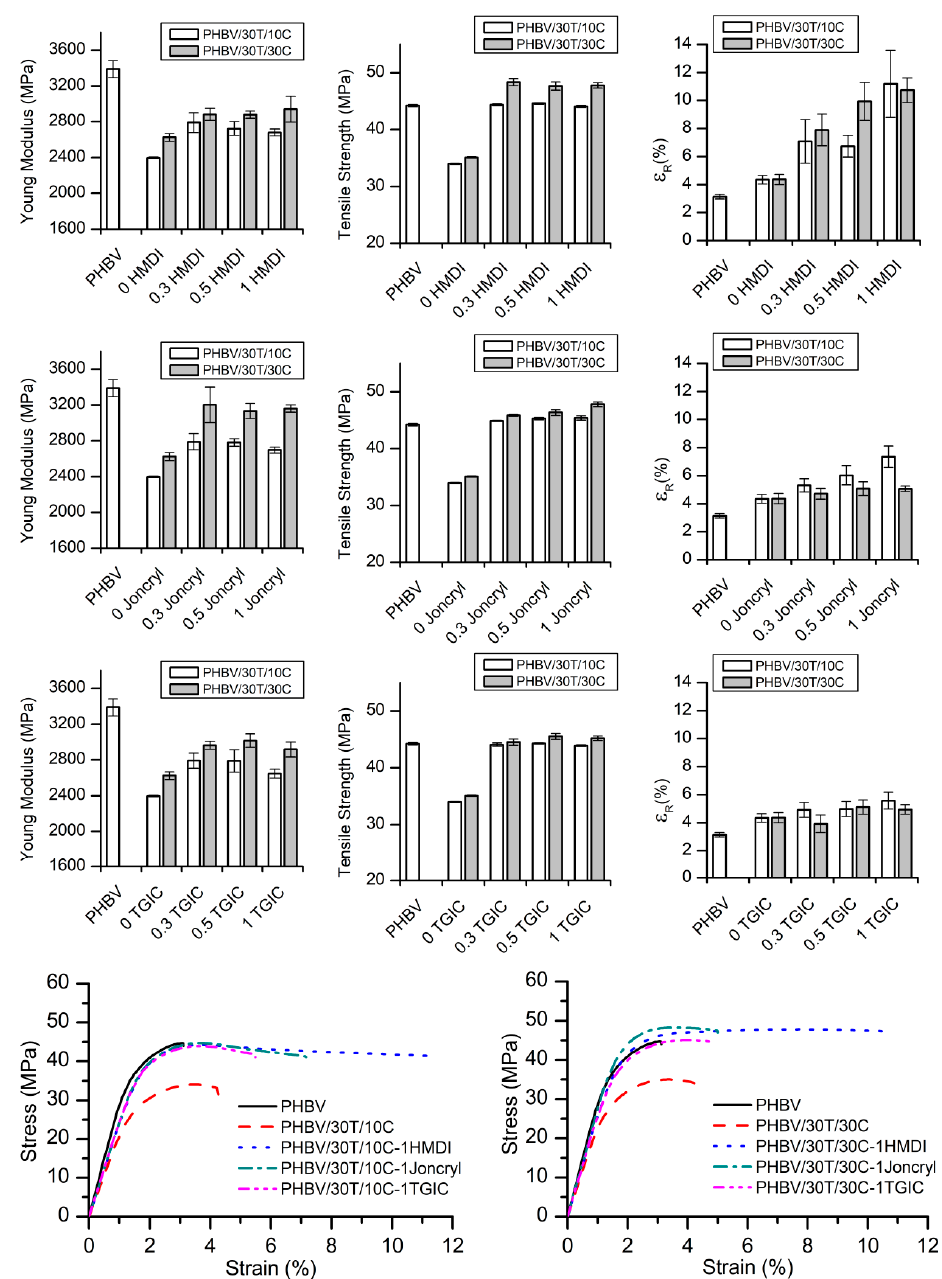
Figure 7. Mechanical properties of the neat PHBV and PHBV/TPU/Cellulose blends and representative stress–strain curves of neat PHBV, PHBV/30T/10C, and PHBV/30T/30C systems with and without 1 phr reactive agents.